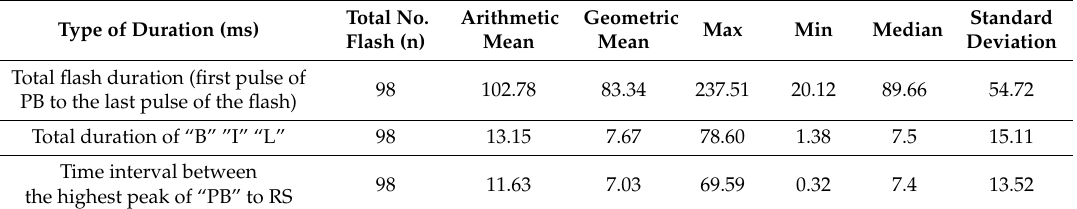
Table 1. The overall view of the dataset and the type of duration of the trains. Type of Duration (ms)